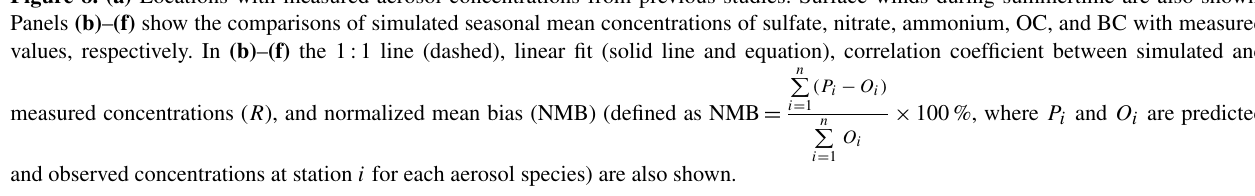
n P × 100%, where P i and O i are predicted O i i = 1